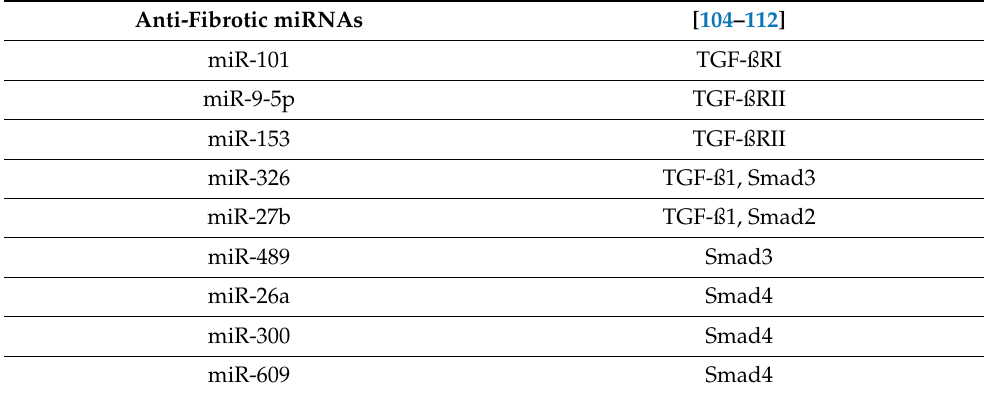
Table 2. MicroRNAs regulate TGF- β /SMAD signalling during